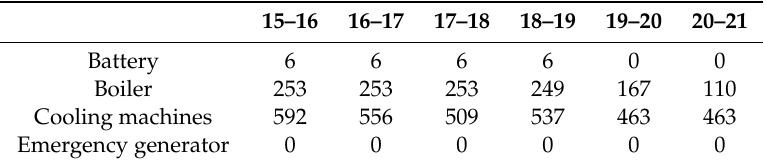
Table 13. Baselines for iteration 4.